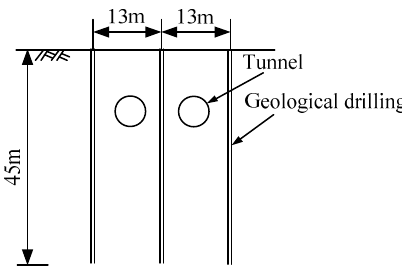
Figure 7. Sectional view of the geological drilling holes.